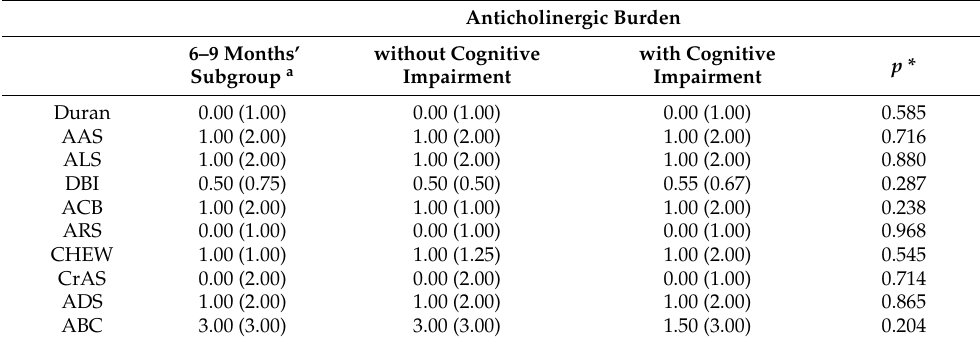
Table A4. Anticholinergic burden by all the scales in subgroup of patients evaluated on 6–9 months, with and without cognitive impairment.